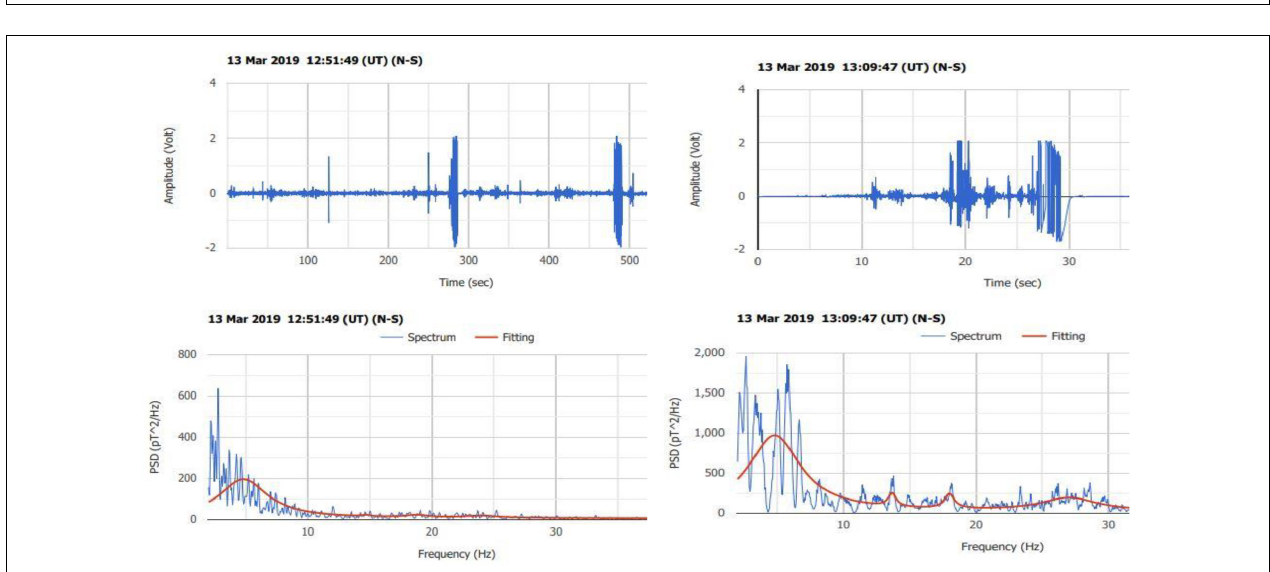
FIGURE 6 | Left panel : two vibrations of the coil by hand in the N-S and E-W directions (narrow stripes). Right panel : two additional intensive vibrations in clock and anti-clock directions by hand made 20 min later.